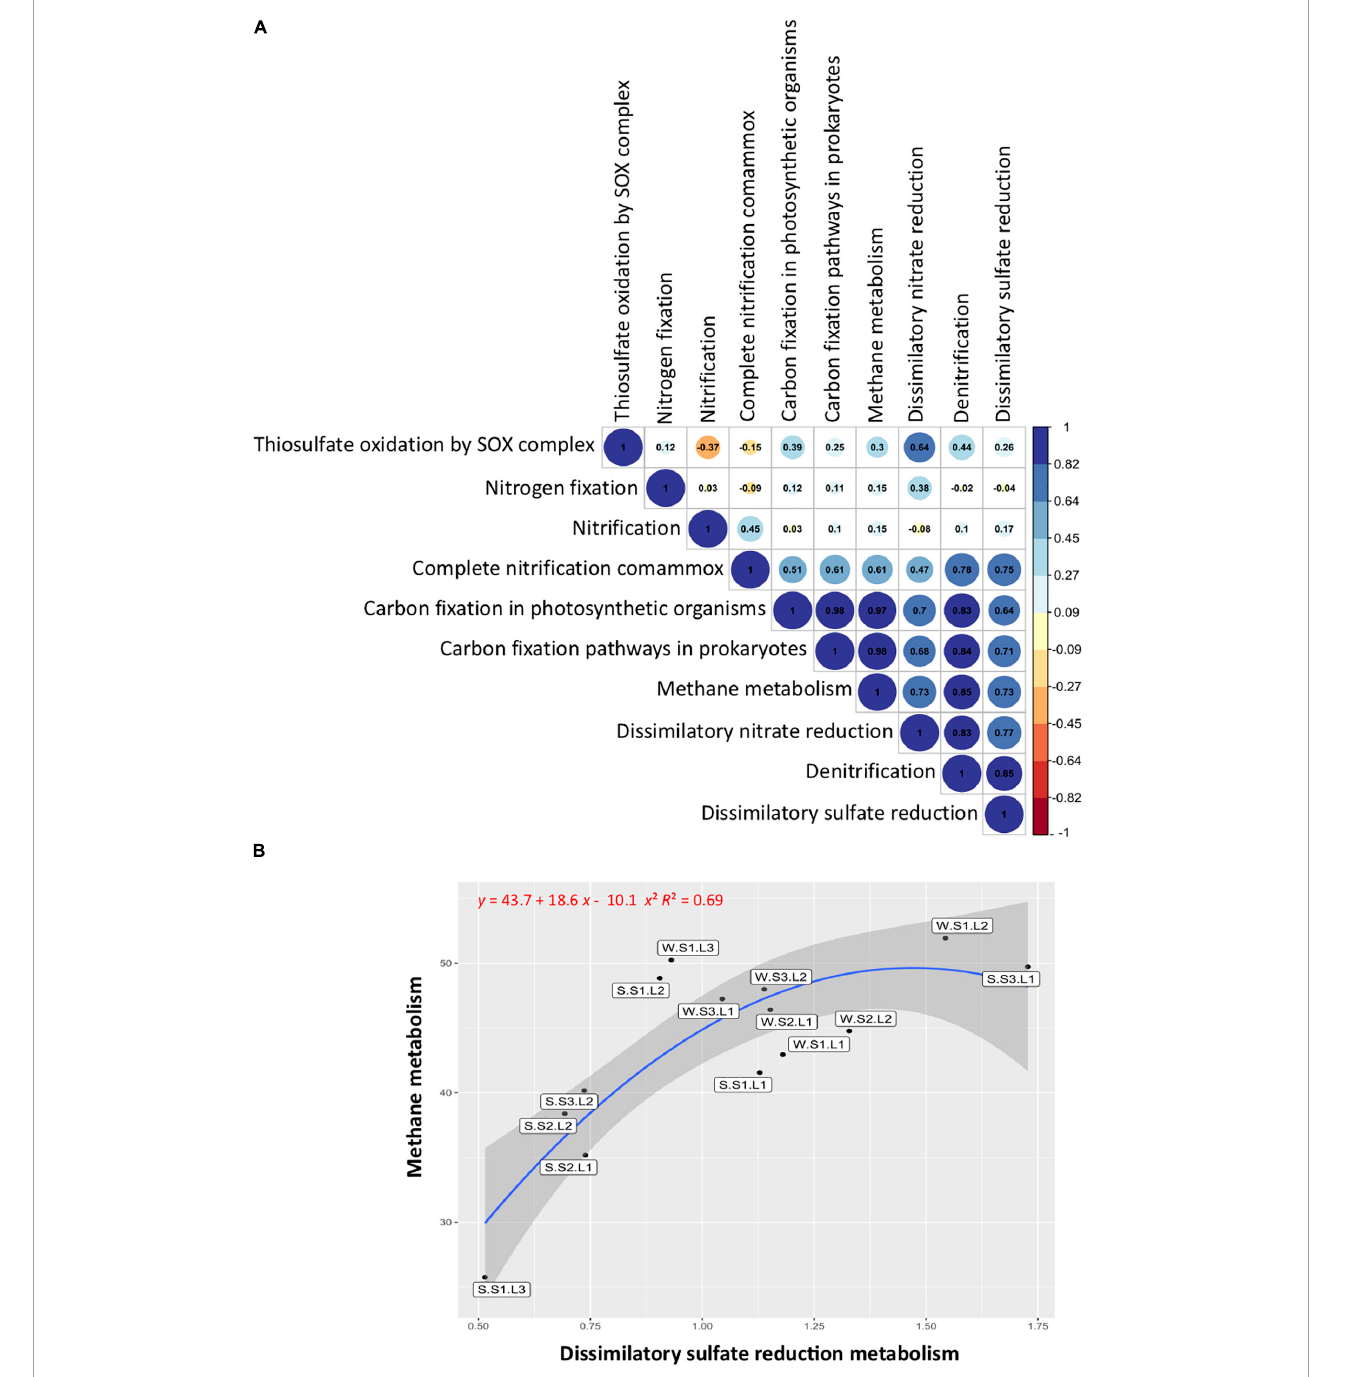
FIGURE6 Functional group correlations and distributions. (A) Pearson’s correlations between sulfur, nitrogen, and carbon metabolisms. Blue, positive correlations; red, negative correlations. (B) Correlation between methane and dissimilatory sulfate reduction metabolisms. Labels indicate sample names: seasons, summer (S, dry period) and winter (W, wet period); stations (S1, S2, S3); layers (L1, L2,